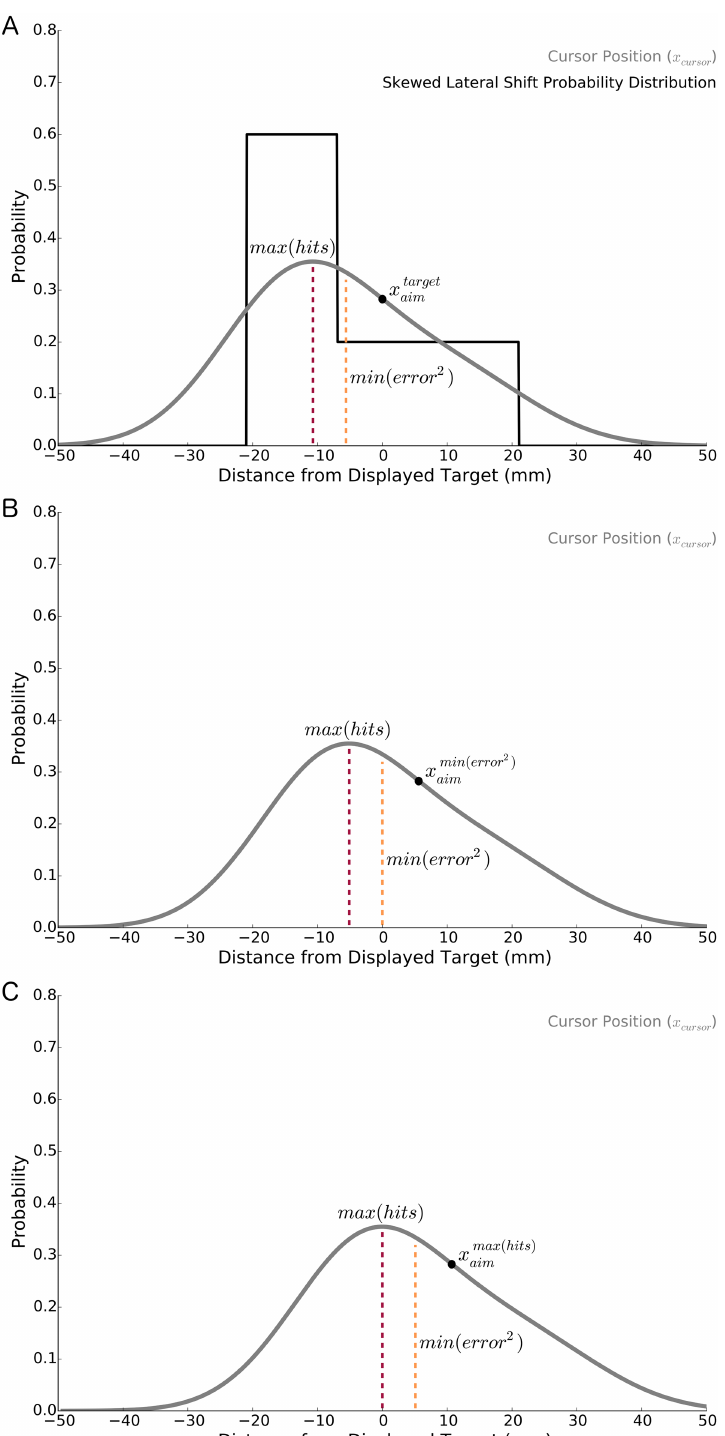
Fig 4. A) In Experiment 2 we used skewed probabilitydistributions (black line, skewed-right distribution shown) to laterally shift the cursor from the true hand position.These lateral shifts were experienced by participants receivingerror feedback, reinforcement feedback,or both forms of feedback. A, B, C) The x -axes representthe distancefrom the displayedtarget and the solid grey curve represents the probabilityof cursor position( y -axes) given intendedaim of the hand, movement variability, and the skewed lateral shift